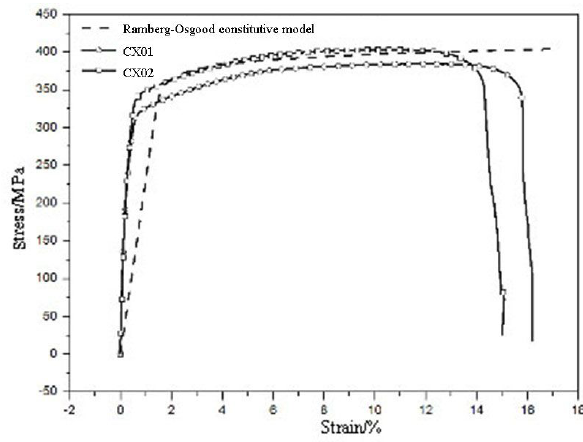
Figure 3: Comparison between experimental curves with Ramberg- Osgood